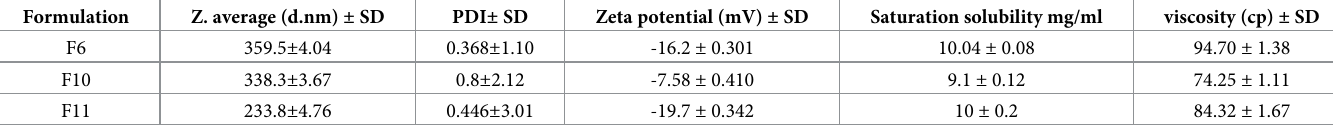
Table 3. Zeta potential and average size of oily droplets of Iodine SNEDDS.